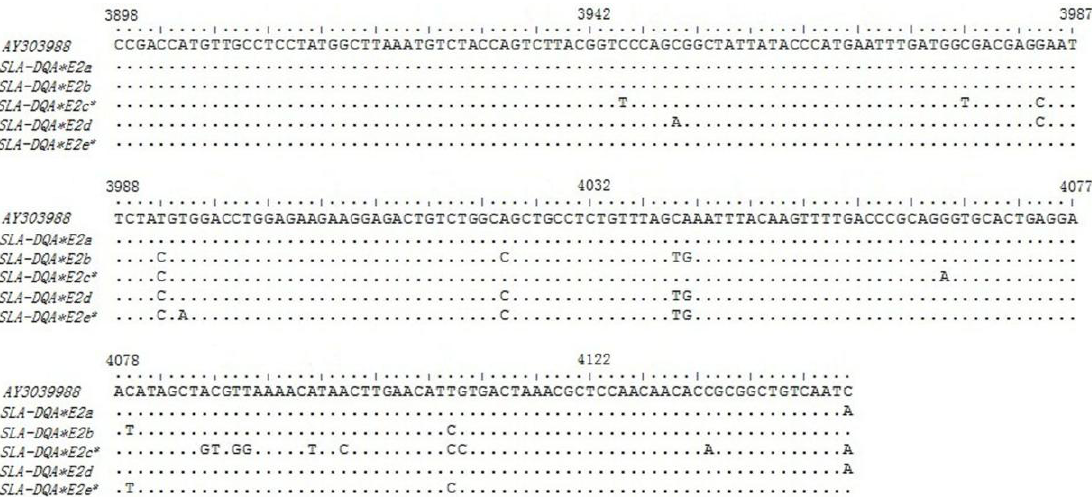
Figure 2. Alignment of the SLA-DQA exon 2 allele nucleotide sequences refer to the sequence AY303988. Sequences correspond to positions 3898-4146 were the complete exon 2. Identical nucleotides are replaced by · and the substitutions are written as letters. Newly identified sequences are marked with * which have assigned GenBank accession numbers.